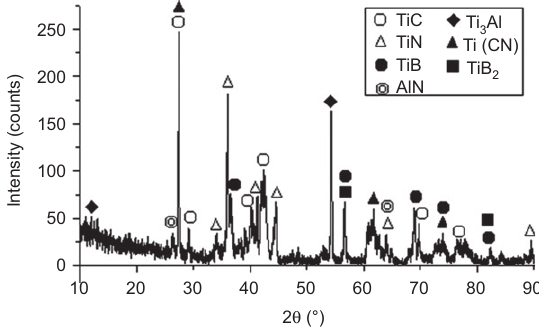
Figure 1 XRD pattern of the composite coating in sample 1.